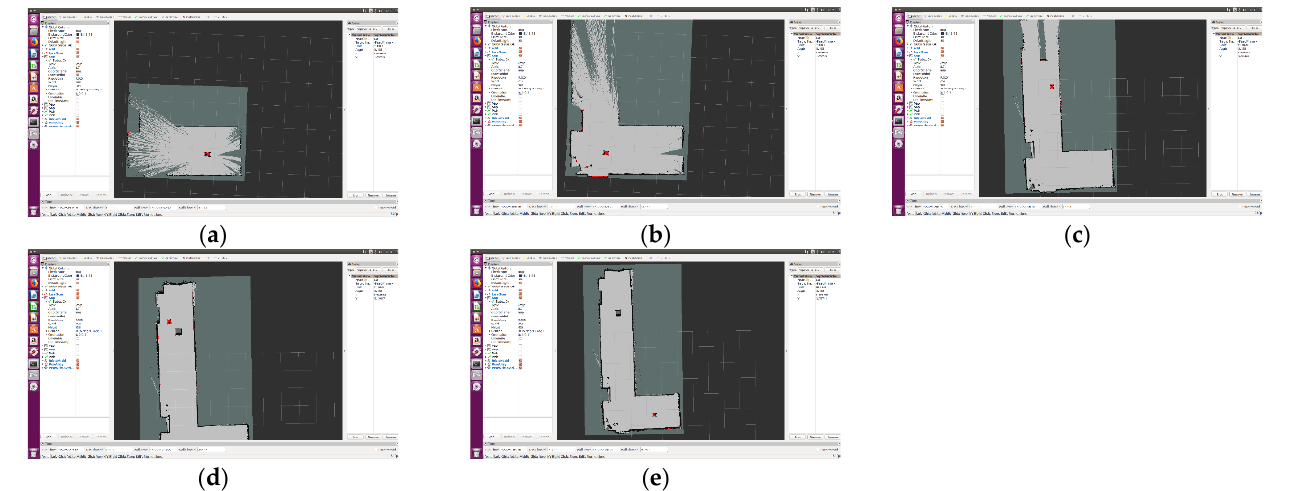
Figure 21. Mapping experiment in Rviz. ( a ) Start mapping; ( b ) Turn right; ( c ) Avoid the carton; ( d ) Bypass the carton; ( e ) Back to the start point.